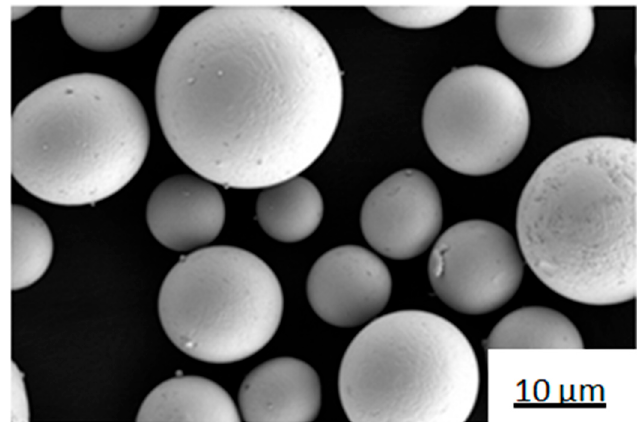
Figure 1. Micromorphology of Fe-based alloy powder.